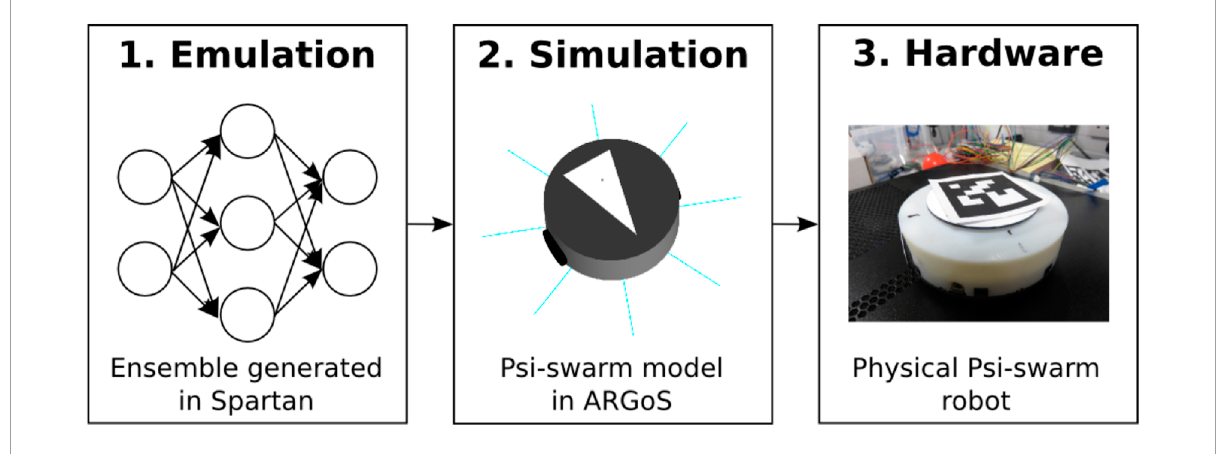
FIGURE 2 Framework for the experiments in this study. 1) Emulation is generated from different machine learning techniques in order to perform an enriched model analysis from a macro perspective which could not be possible to do in simulations due to constraints in time, battery span, and computational power. 2) Simulations are used to study the model from a micro perspective. 3) Experiments in hardware are used to validate the results shown in emulation and